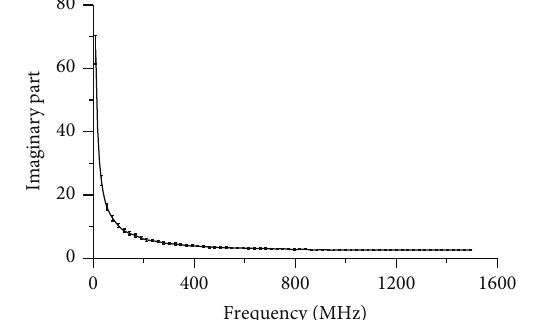
Figure 6: The imaginary part statistical characteristic of sample #5 dielectric permittivity under di ff erent frequency.